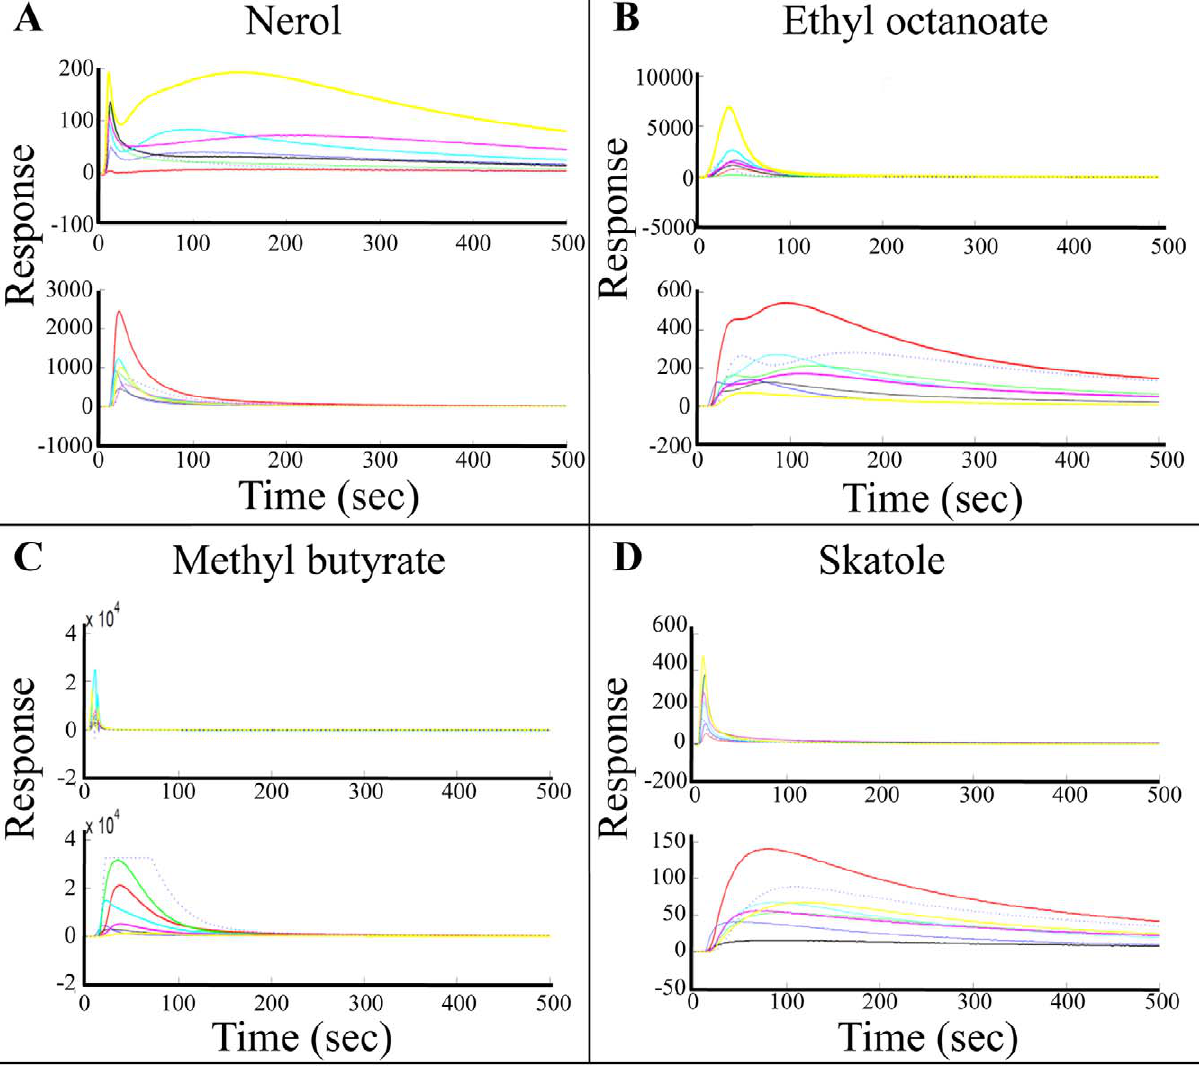
Figure 4. Raw eNose signal amplitude did not reflect pleasantness. Four typical odorant eNose signals of both the QMB sensor module (upper panels) and MOX sensor modules (lower panels). Each line shows the dynamic response of one sensor. Note that both pleasant and unpleasant odorants generated both strong and weak responses. A and B . An example of two very pleasant odorants. C and D An example of two very unpleasant